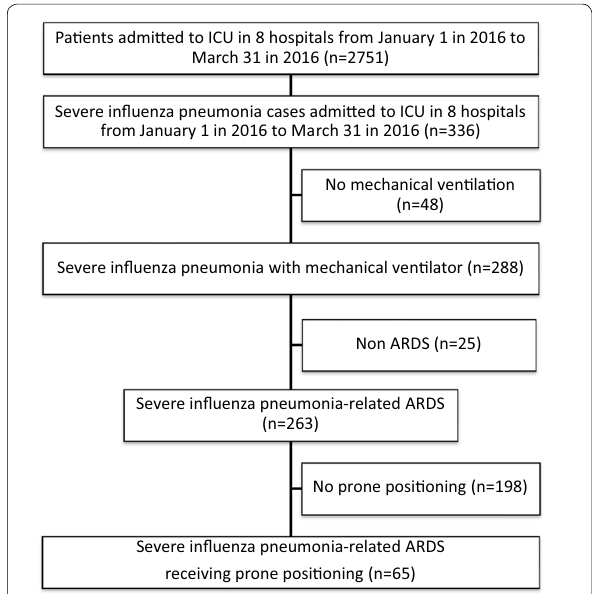
Fig. 1 Enrollment and follow‑up of the study participants. ICU the intensive care unit, ARDS acute respiratory distress